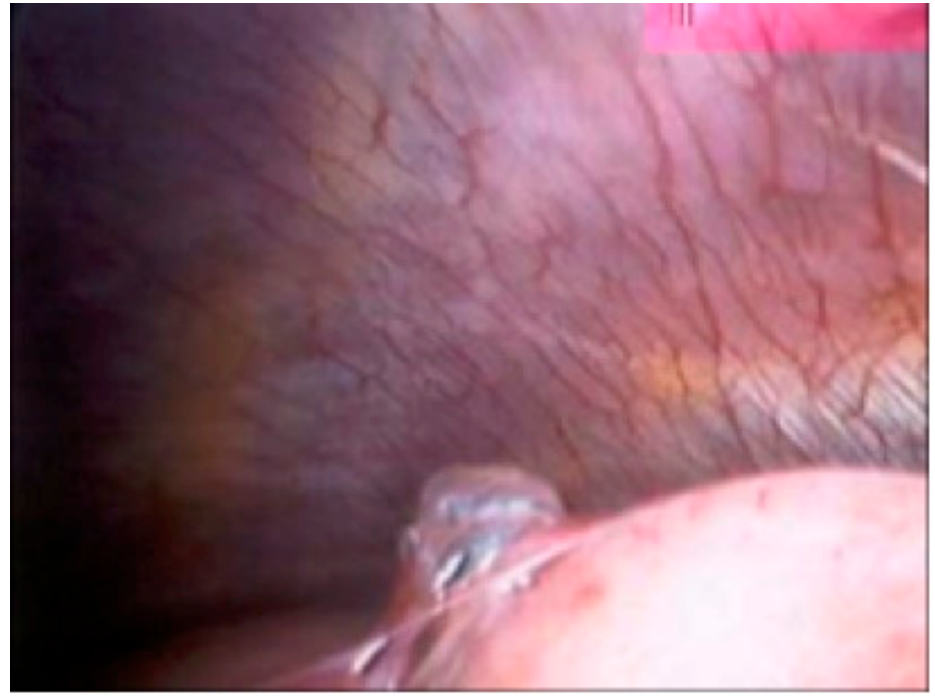
Figure 3. Thoracoscopic view of a bleb on the visceral pleural surface (Courtesy of M Noppen). The true incidence of ELC in PSP patients (compared to the similar patient groups without pneumothorax) is not clear. One early study found these changes in 81% of non-smoking patients with PSP (predominately in the upper lobes) but not in healthy controls. Bilateral ELC were seen in 15% of patients with unilateral pneumothorax [9]. However, a larger series of 250 healthy individuals with no prior history of pleural dis- ease undergoing thoracoscopic sympathectomy found a 6% incidence of apical blebs, which were more prevalent in slim individuals (BMI < 22 kg/m 2 ) who smoked [15].